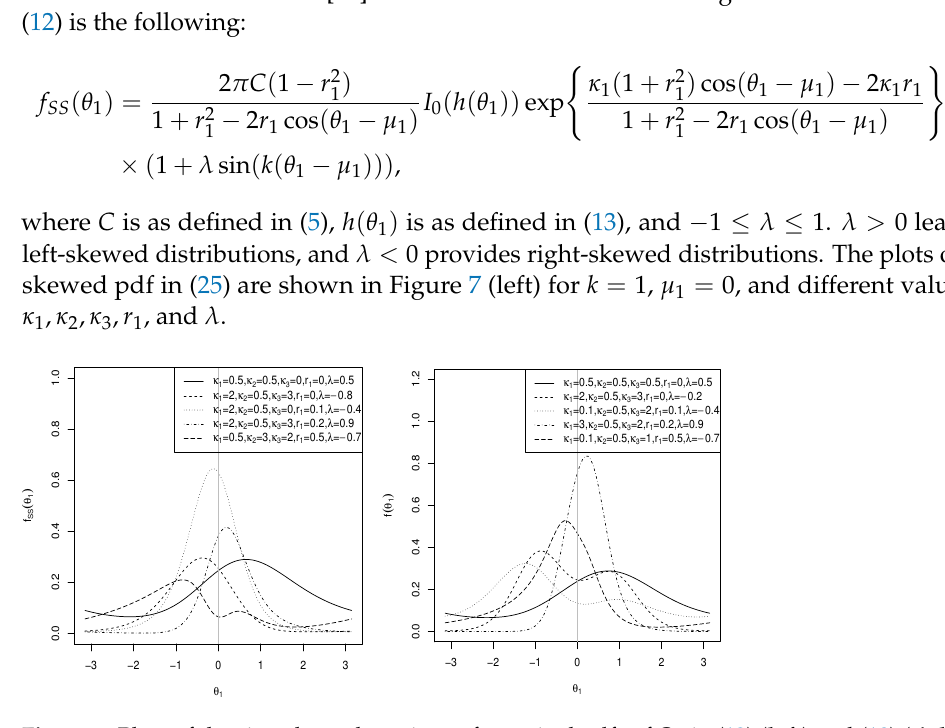
Figure 7. Plots of the sine-skewed versions of marginal pdfs of Θ 1 in (12) ( left ) and (18) ( right ) for k = 1, µ 1 = 0 and different parameter